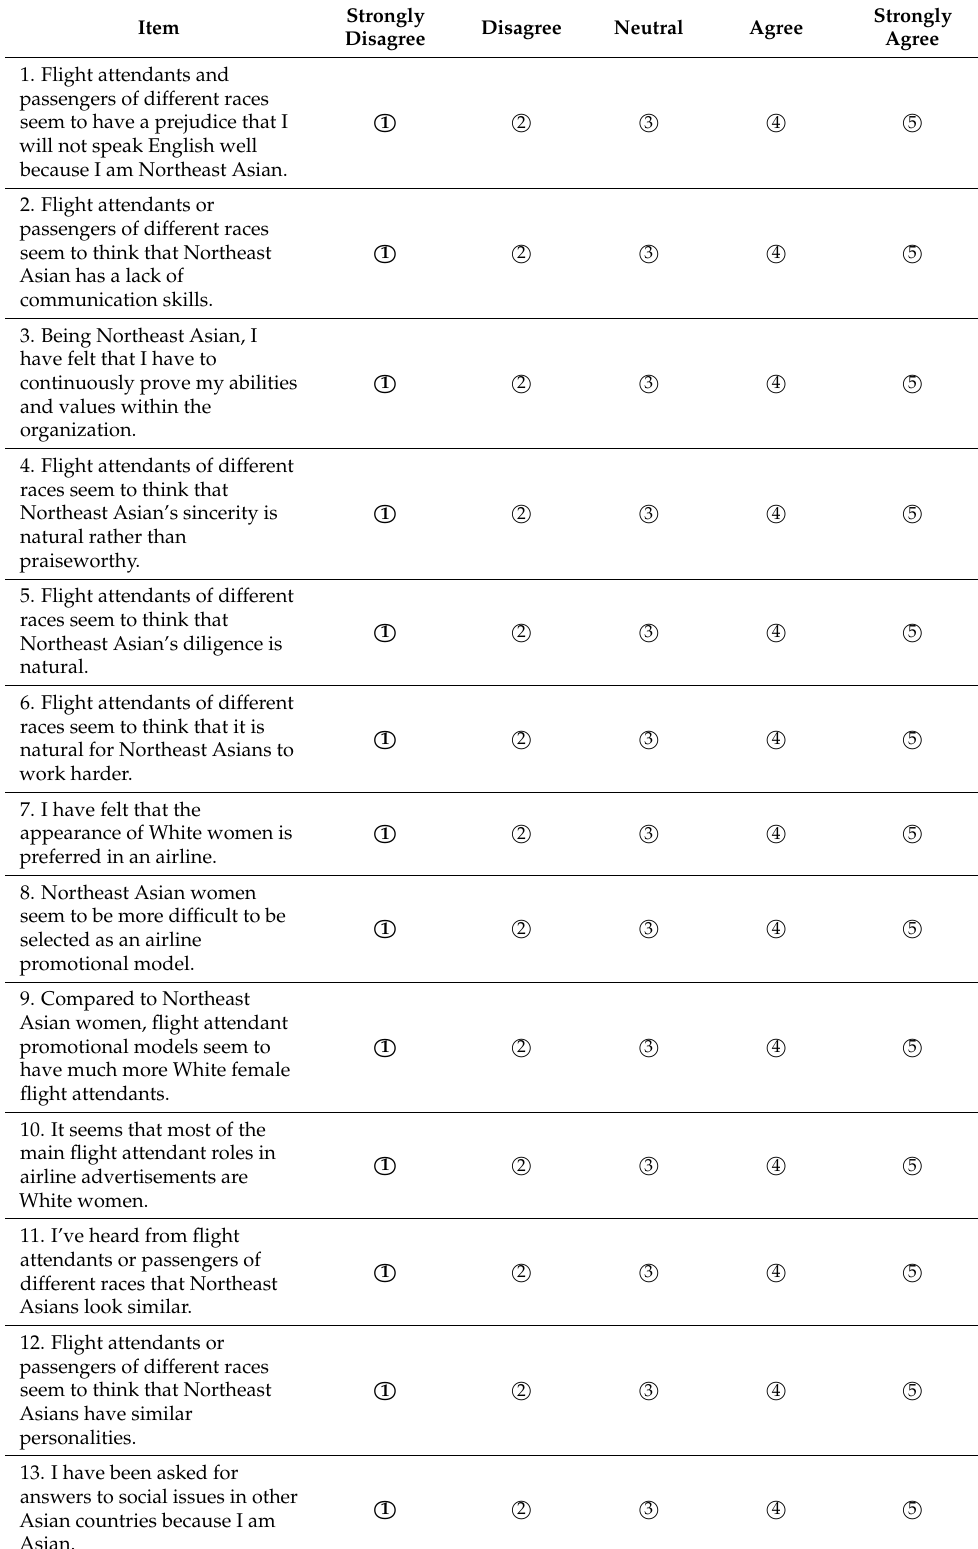
√ Table A1. Please mark ( ) the number that matches your opinion. ( 1 (cid:13) Strongly disagree 2 (cid:13) disagree 3 (cid:13) Neutral 4 (cid:13) agree 5 (cid:13) Strongly agree). Strongly Item Disagree Neutral Agree Disagree